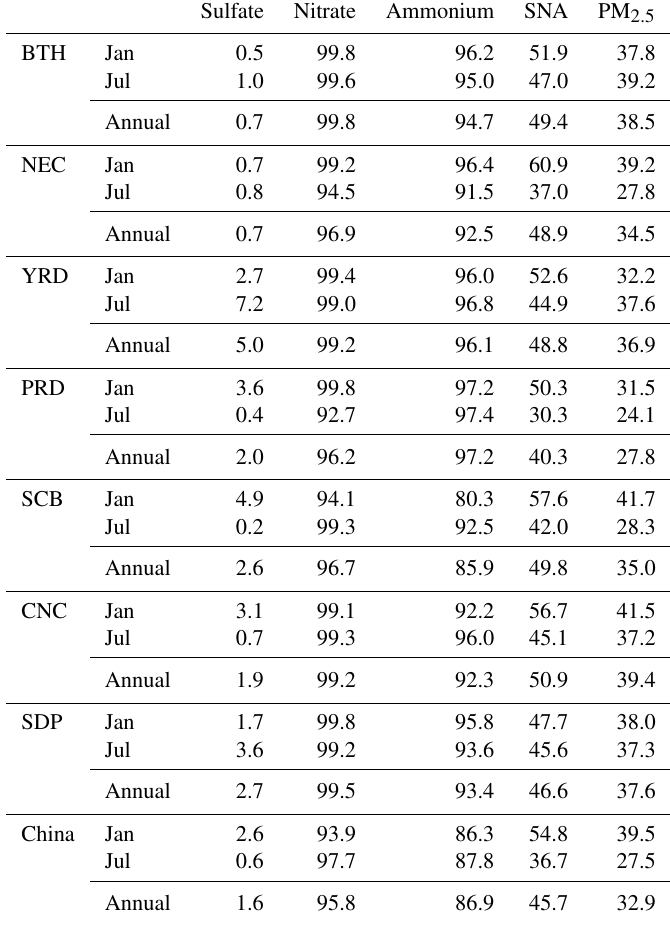
Table 5. The variation percentage (%) of sulfate, nitrate, ammonium, and SNA mass concentration associated with agriculture NH 3